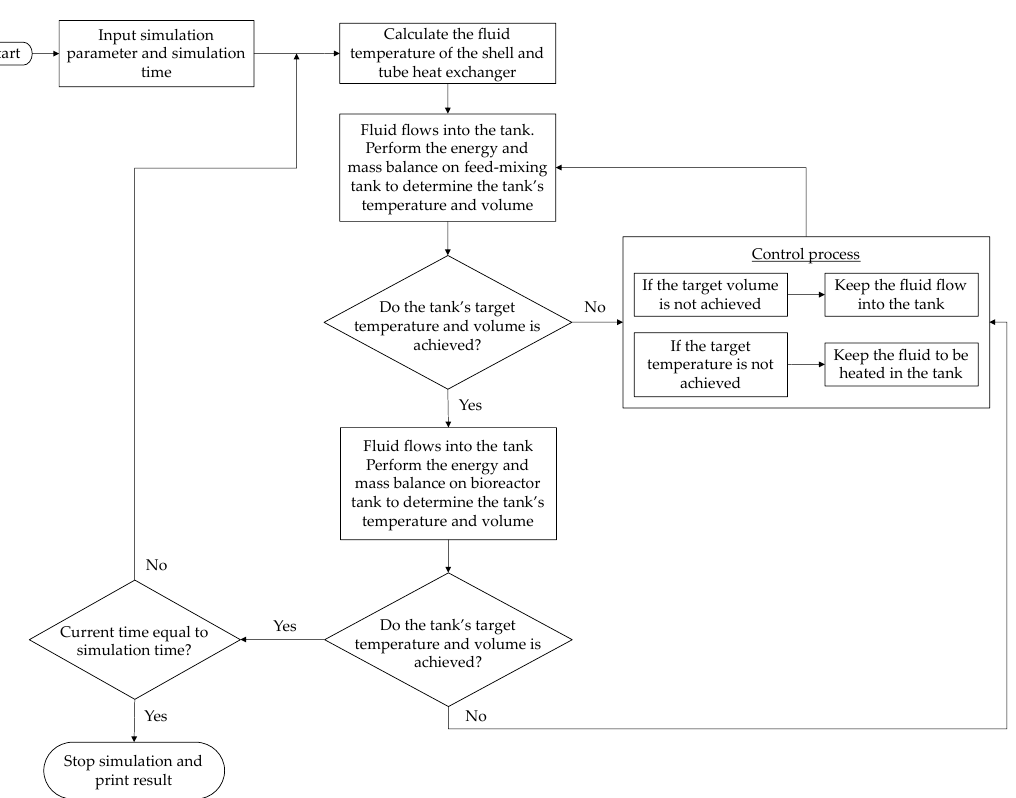
Figure 14. Simulation flowchart for the bio-integrated gasification combined cycle model.